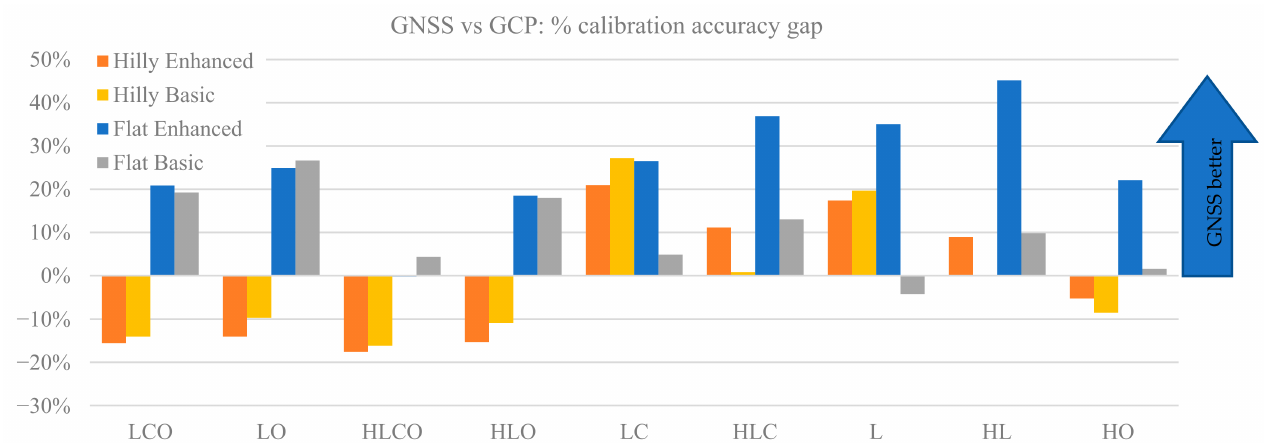
Figure 7. Percentage accuracy gap in camera distortion modelling between GCP and the GNSS case for each of the nine block configurations as a function of the terrain type (Flat, Hilly) and of the control tightness (Basic or